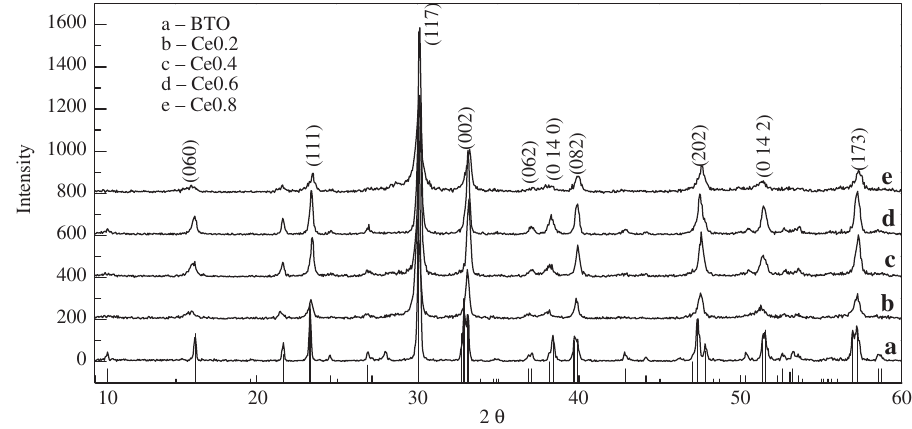
Figure 3 XRD of powders with different Ce conconts annealed at 700 °